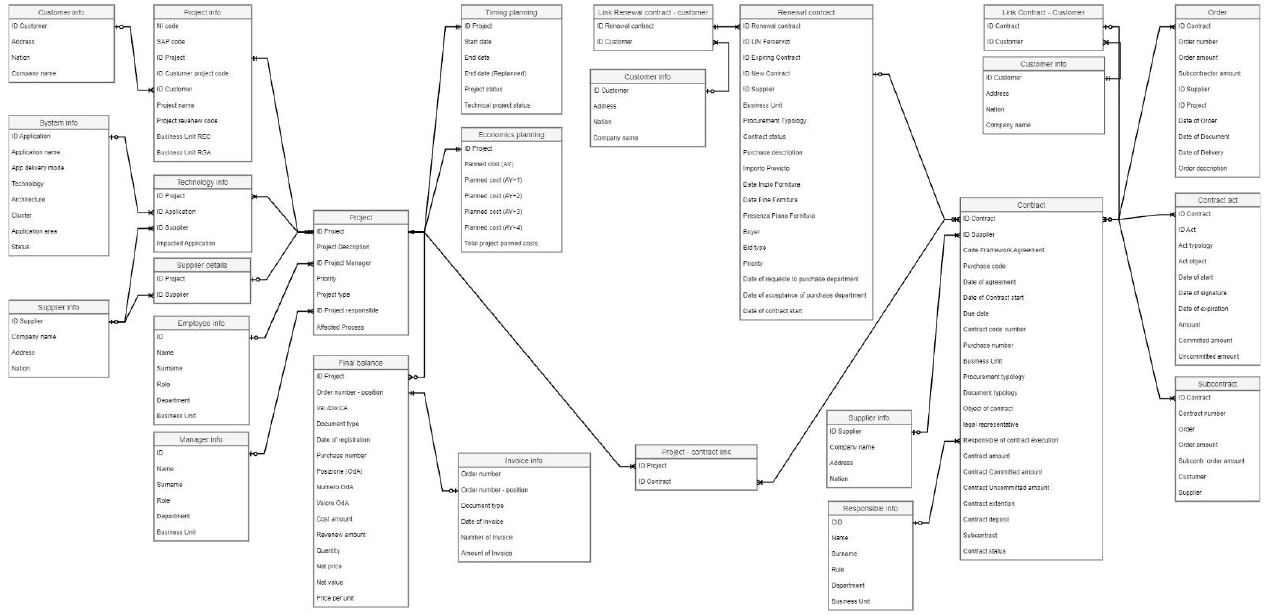
Figure 4. ER diagram data model design using the crow’s foot notation. The open - source software used for the model design was draw.io (tables’ elements name were manipulated and de-identified in order not to reveal the intellectual property of the units involved).